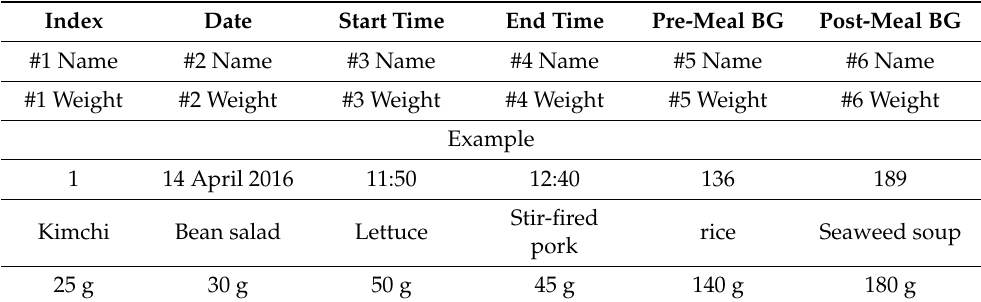
Figure 4. The proposed food tray and its implementation. Table 5. The obtained meal information from the food tray.